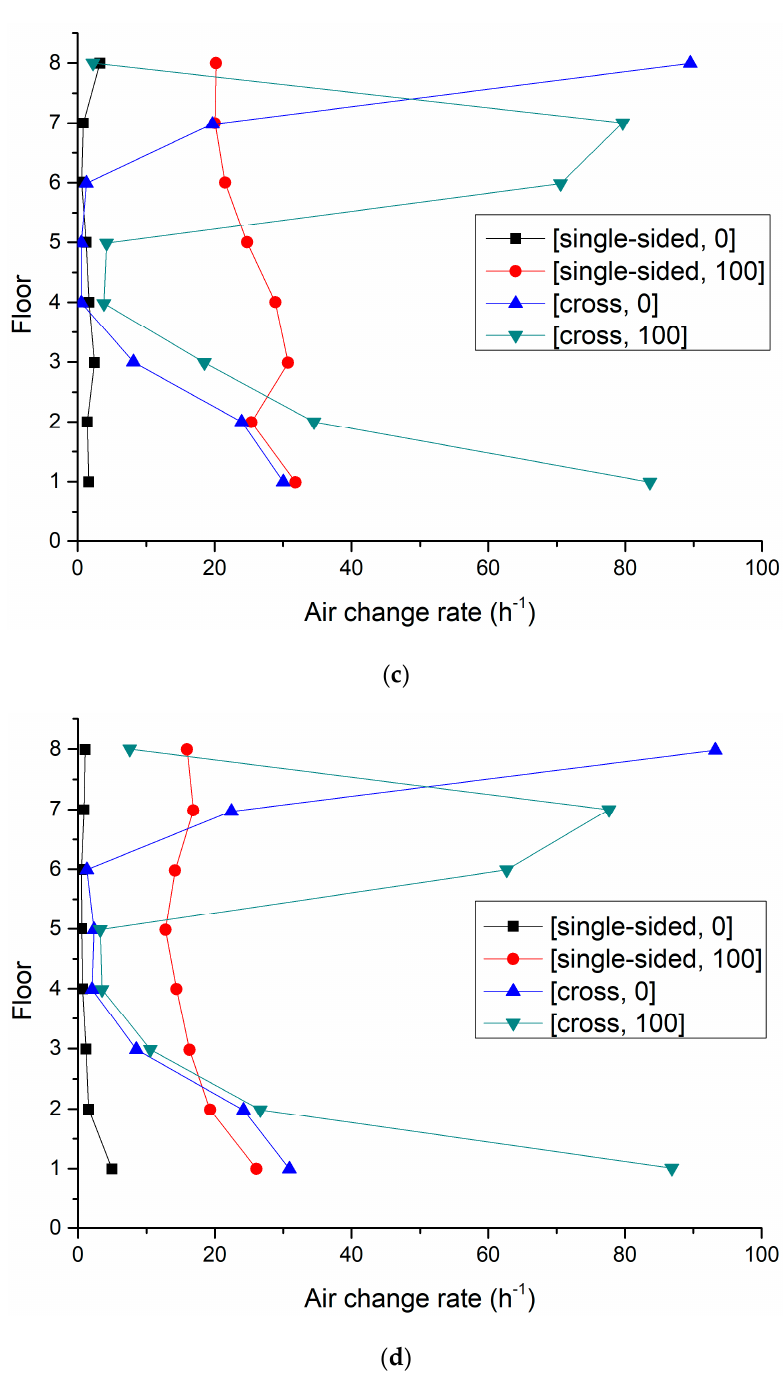
Figure 6. Air change rate of different building floors in ( a ) windward side of Building 1, ( b ) leeward side of Building 1, ( c ) windward side of Building 2, and ( d ) leeward side of Building 2.